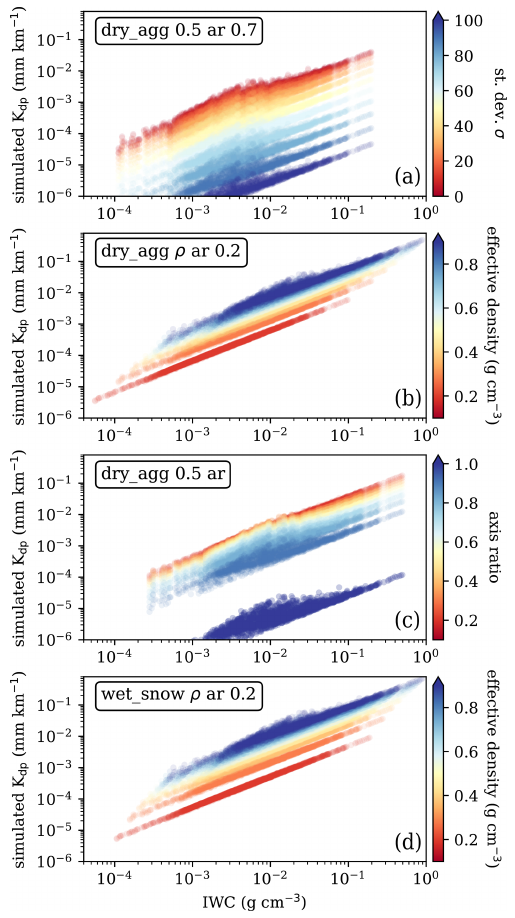
Figure 8. Results of simulated K dp as a function of IWC for dry aggregates (a–c) and wet snow (d) , varying the standard deviation of the tilt angle distribution (a) , the effective density (b) , the axis ratio (c) , and the effective density of wet snow (d)